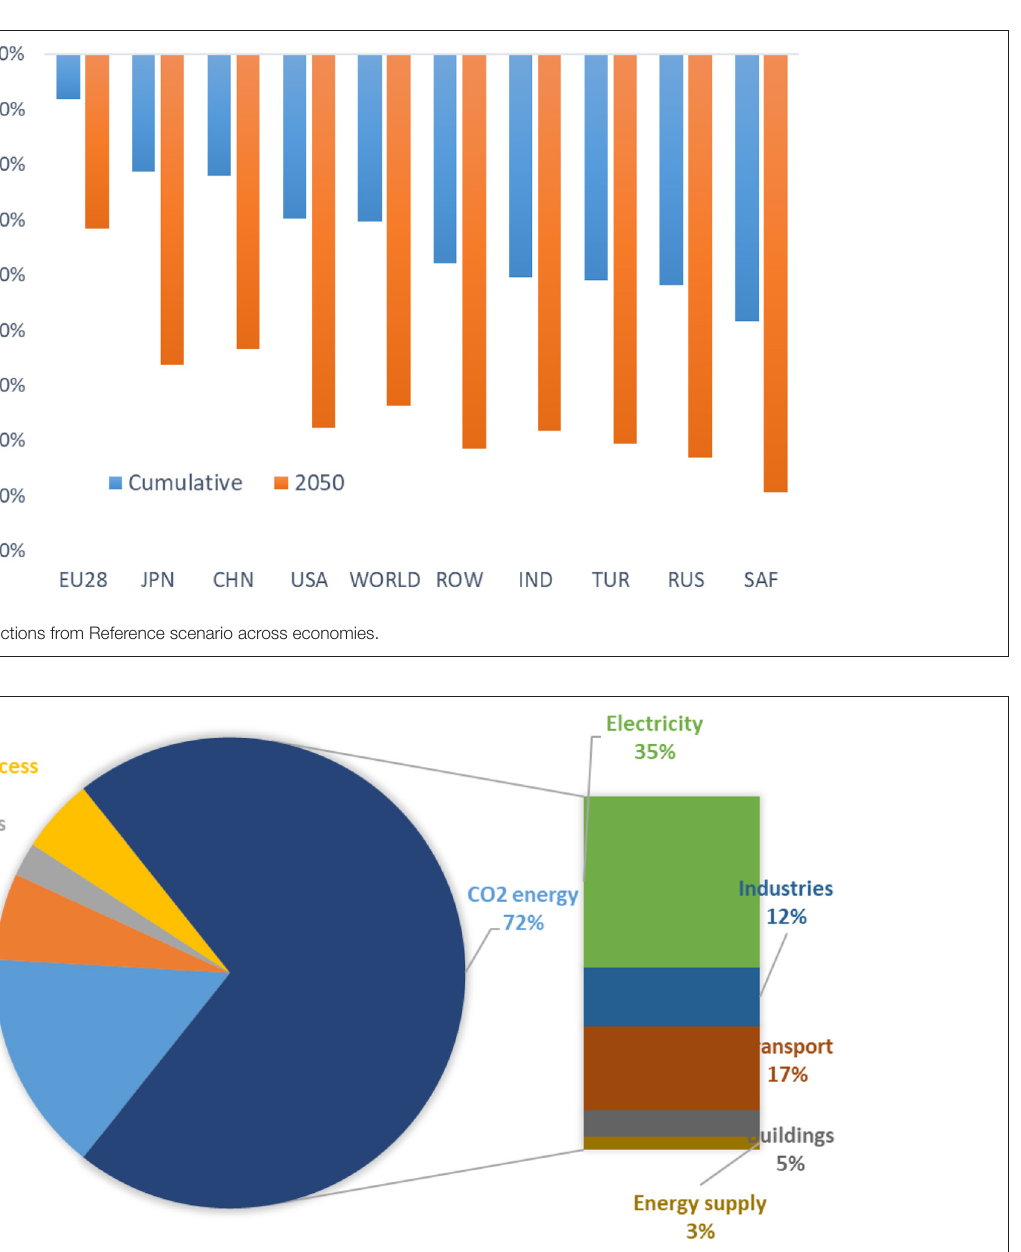
FIGURE 6 | Distribution of the GHG mitigation effort in the 2DEG scenario by